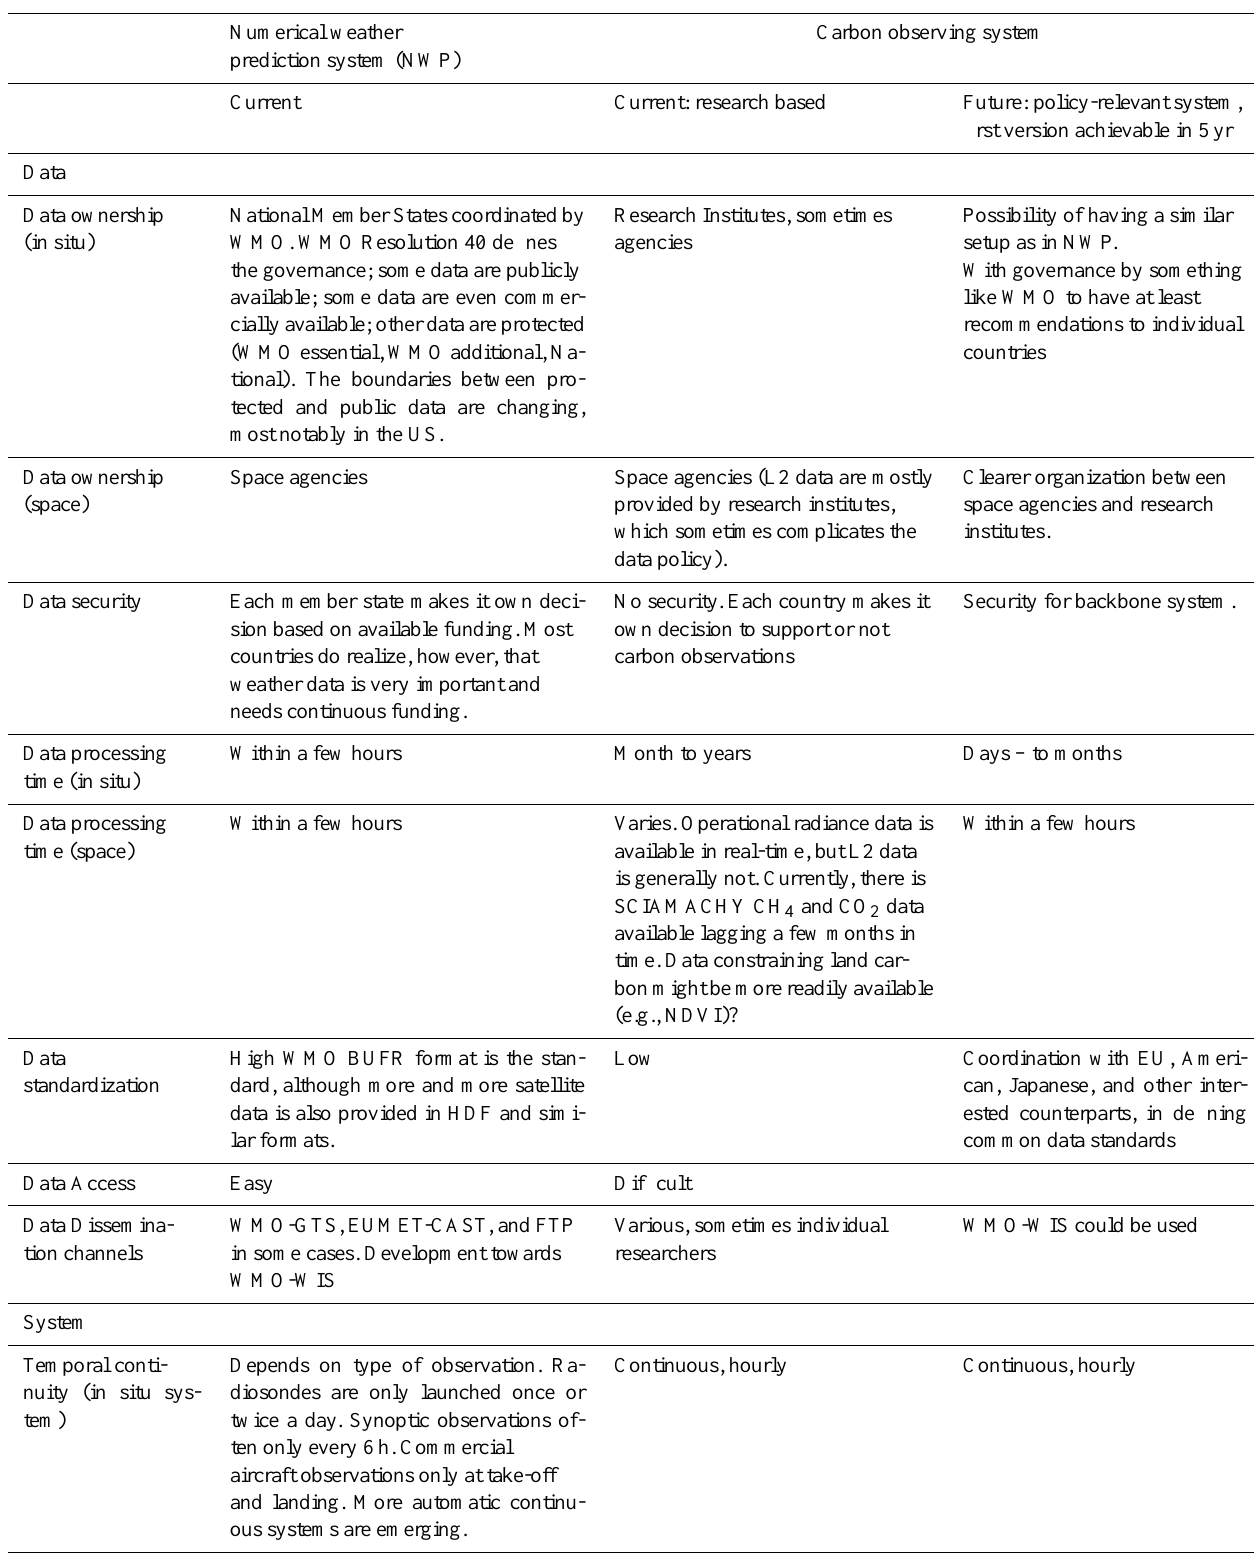
Table 2. Comparison between numerical weather prediction systems and Carbon Observing system for atmospheric data (infrastructure, management, stewardship), system attributes, and algorithms used for delivering products to end users. For oceanic CO 2 data for instance the data are already reported on standardized